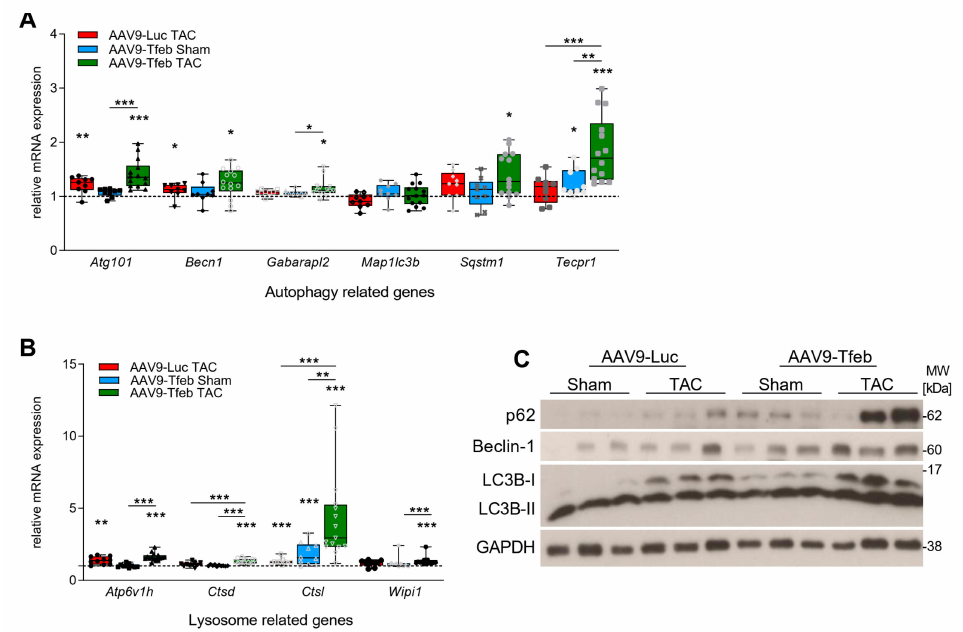
Figure 5. Validation of selected genes enriched in the GO-term analysis by qRT-PCR and Western blot analysis. ( A , B ) qRT-PCR to quantify gene expression of autophagy related genes ( A ) of autophagy- related 101 ( Atg101 ), Beclin-1 ( Becn1 ), gamma-aminobutyric acid A receptor-associated protein-like 2 ( Gabarapl2 ), microtubule-associated proteins 1A/1B light chain 3B ( Map1lc3b ), sequestosome 1 ( Sqstm1 /p62), tectonin beta-propeller repeat containing 1 ( Tecpr1 ), and lysosome related genes ( B ) ATPase, H+ trans- porting, lysosomal V1 subunit H ( Atp6v1h ), cathepsin D ( Ctsd ), cathepsin L ( Ctsl ) and WD repeat domain phosphoinositide-interacting protein 1 ( Wipi1 ) in the interventricular septum from sham (AAV9-Luc, AAV9-Tfeb: n = 9) and TAC (AAV9-Luc: n = 9, AAV9-Tfeb: n = 14) operated mice. Genes involved in autophagy (GO:0006014) and lysosome (GO:0005764) are separately shown. Data were normalized to geometric mean of Mrpl13 , Ipo8 and Pgk1 and presented as mean ± SEM. Values indicate relative expression levels related to the AAV9-Luc sham group, which group mean was set to 1 ( ± SEM). * p < 0.05; ** p < 0.01; *** p < 0.001. ( C ) Western blot of proteins from left ventricular tissue lysates of sham (AAV9-Luc and AAV9-Tfeb) and TAC (AAV9-Luc and AAV9-Tfeb) treated mice ( n =